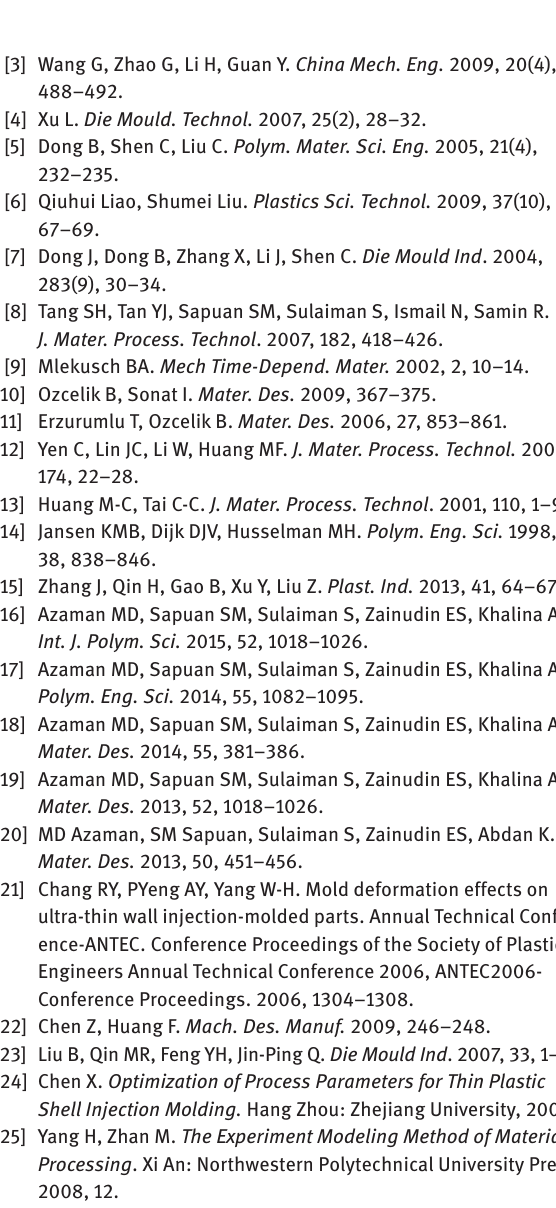
Figure 14: UG fitting graphs: (A) before optimization and (B) after